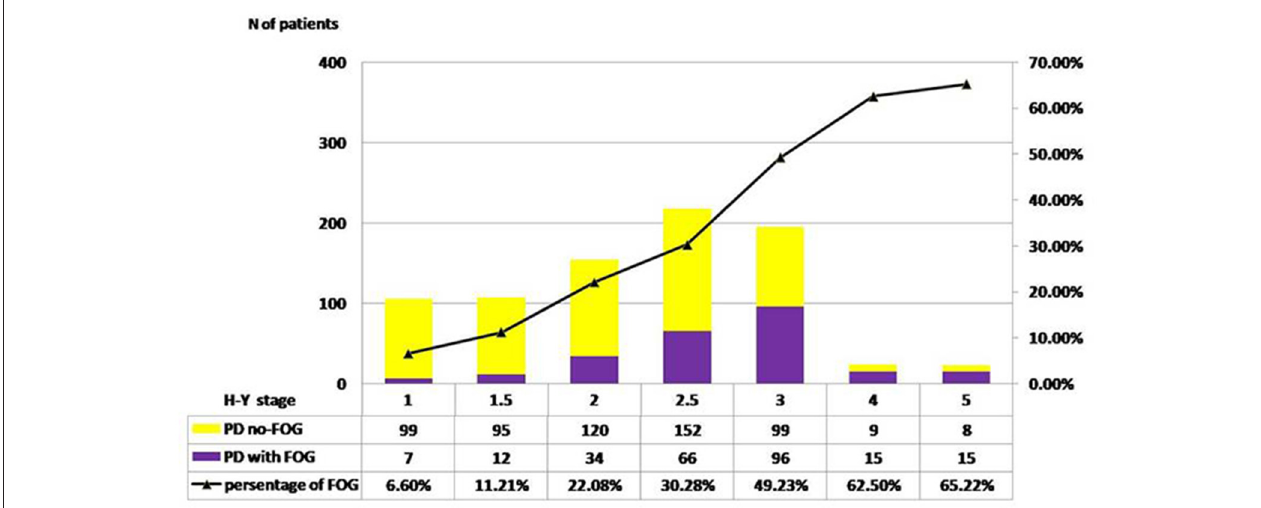
FIGURE 1 | Pareto chart of FOG frequency across H-Y stages. H-Y 1.0, the prevalence of FOG was 6.60%;H-Y 1.5, the prevalence was 11.21%; H-Y 2.0, 22.08%; H-Y 2.5, 30.28%; H-Y 3.0, 49.23%; H-Y 4.0, 62.50%; H-Y 5.0, 65.22%. A significant linear trend across H-Y stages was disclosed by result χ 2 test ( p <